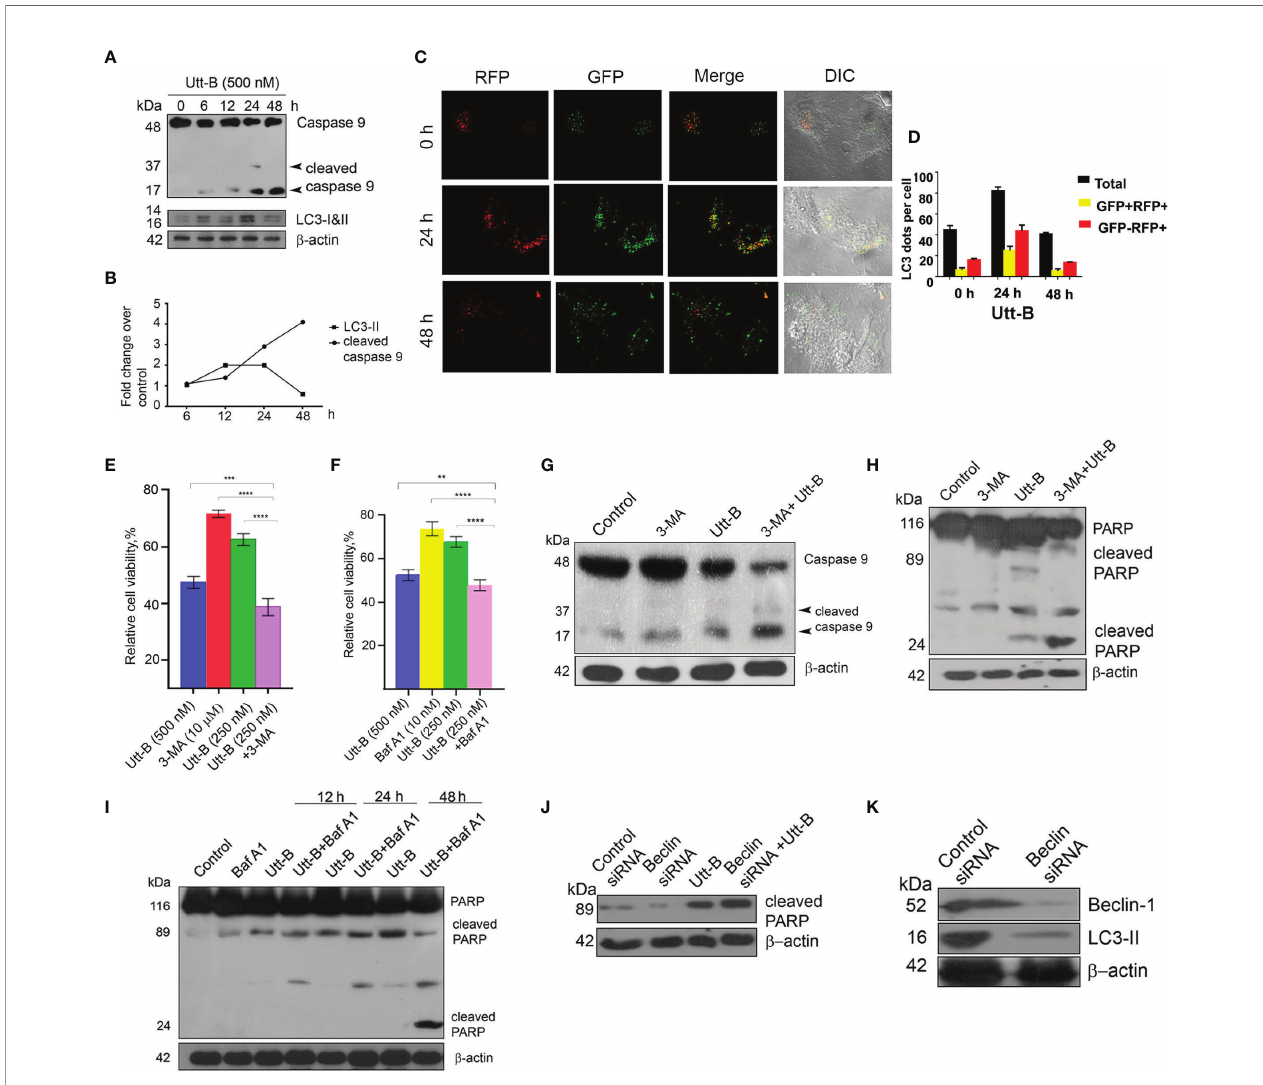
FIGURE 3 | Inhibition of autophagy enhances Utt-B-mediated apoptotic program (A, B) Utt-B treatment induces the cleavage of caspase 9 at 24 h and increases further up to 48 h, and accumulation of LC3-II at 12 h and is maintained up to 24 h, followed by its degradation by 48 h. (C, D) RFP-GFP-LC3 tagged assay shows more mRFP + -GFP punctae in HepG2 cells, up to 24 h followed by a signi fi cant reduction in the number of punctae at 48 h. (E, F) Co-treatment with both the inhibitors 3-MA and Baf A1enhances Utt-B-mediated cytotoxicity in HepG2 cells. (G – I) Co-treatment of autophagy inhibitors with Utt-B induces the Cleavage of Caspase 9 and PARP. (J, K) Beclin SiRNA silenced-HepG2 cells exhibit increased expression of cleaved PARP. The error bars represent the Standard Deviation. One-way ANOVA followed by Tukey ’ s post hoc t test analysis was used for statistical comparison between different groups. ***P ≤ 0.001; **P ≤ 0.01. Symbol asterisk (*) represents statistical signi fi cance between control and treatment groups (E, F)